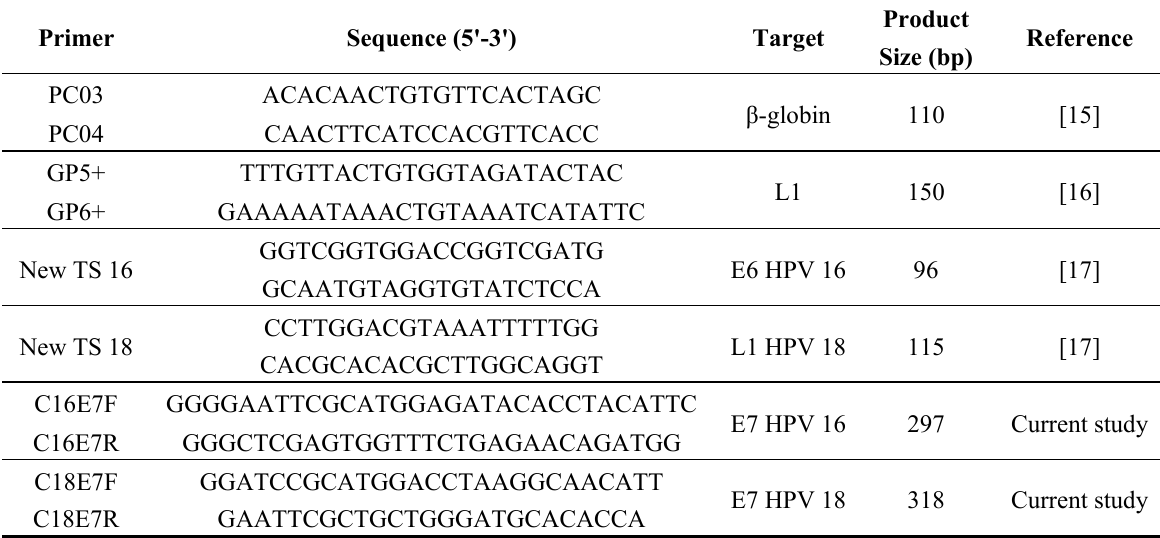
Table 1. Primers used for detection and genotyping of human papillomavirus (HPV) 16 and 18.